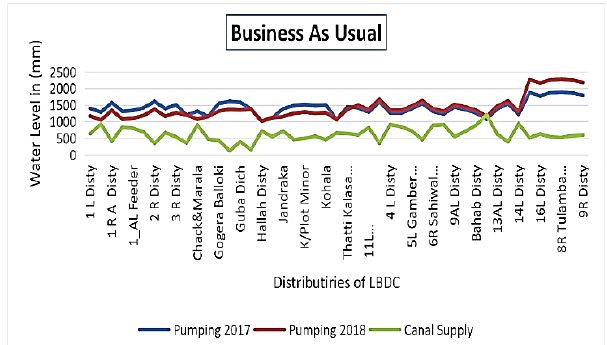
Figure 5: GW abstraction and Canal water supply are Business As Usual